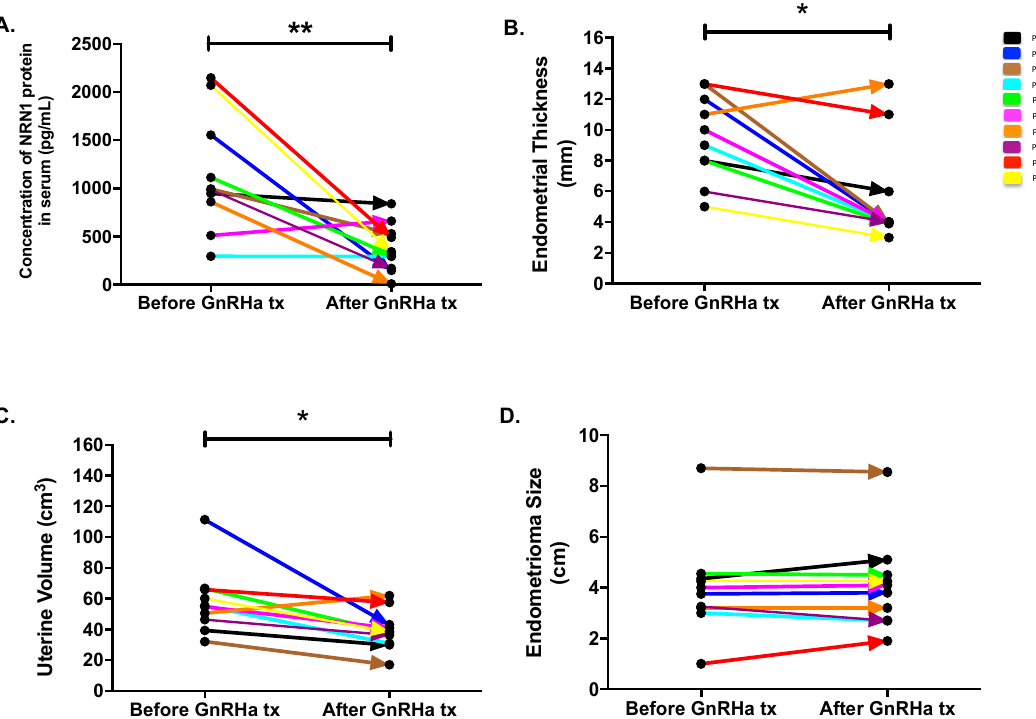
Figure 4. Serum level of NRN1, endometrial thickness, uterine volume and ovarian endometrioma diameter in women with endometriosis following GnRHa treatment. ( A ) NRN1 concentration was measured in the serum from 10 patients with endometriosis before and after GnRHa treatment by ELISA. The concentration of NRN1 in the serum decreased in nine out of the 10 patients. ** p <